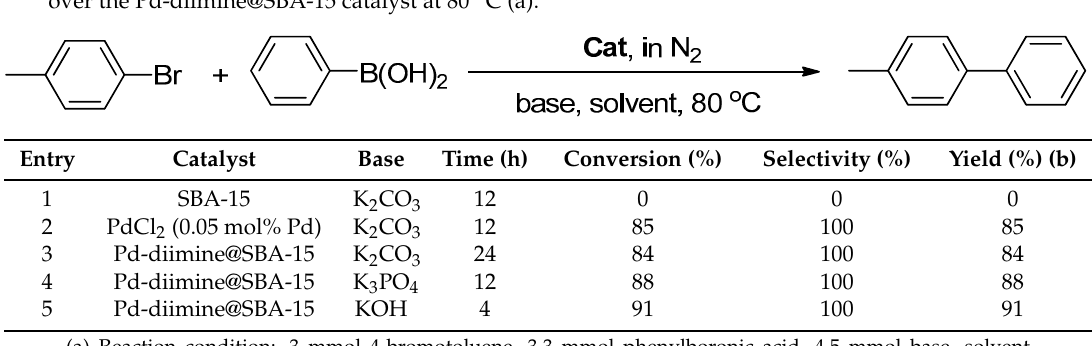
Figure 6. SEM images of ( A ) SBA ‐ 15 and ( B ) Pd ‐ diimine@SBA ‐ 15, and TEM images of ( C ) Pd ‐ diimine@SBA ‐ 15 and ( D ) Pd/SBA ‐ 15.